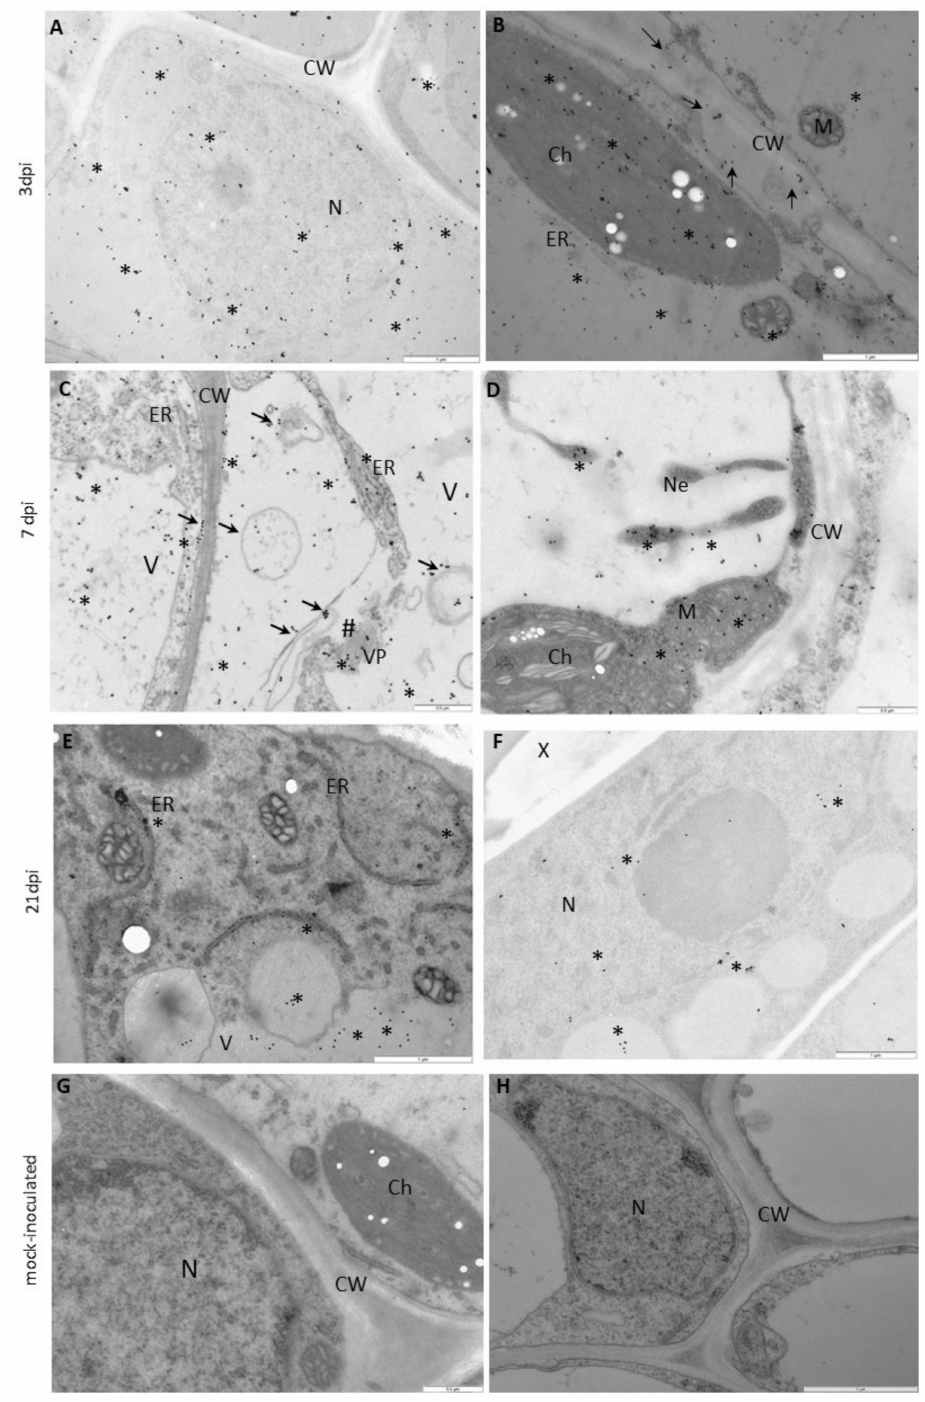
Figure 6. Immunogold labeling of PVY NTN -NIb in Irys and Sekwana leaves: ( A , B ) 3 dpi, ( C , D ) 7 dpi, ( E , F ) 21 dpi, and ( G , H ) mock-inoculated. ( A ) NIb gold deposition (*) in nucleus and cytoplasm in phloem cells. Scale bar: 1 µ m ( B ) NIb deposition (*) in chloroplasts (Ch), mitochondria (M), and apoplast areas (arrows). Scale bar: 1 µ m. ( C ) NIb (*) in vacuoles (V) and apoplasts with membranous and vesicular structures (arrows). Gold granules also occurred in virus particles (VP, #). Scale bar: 0.5 µ m. ( D ) NIb (*) in necrotized protoplasts (Ne) of mesophyll cells. Gold deposition in mitochondria (M) and vacuoles (V). Scale bar: 0.5 µ m. ( E ) NIb (*) in vacuoles (V) and along the ER. Scale bar: 1 µ m. ( F ) NIb (*) in the nucleus (N) in xylem parenchyma cells. Scale bar: 1 µ m. ( G ) Lack of gold deposition in the mesophyll cells of mock-inoculated Irys. Scale bar: 0.5 µ m. ( H ) Lack of gold deposition in the phloem of mock-inoculated Sekwana. Scale bar: 1 µ m. CW—cell wall, ER—endoplasmic reticulum, X—xylem tracheary